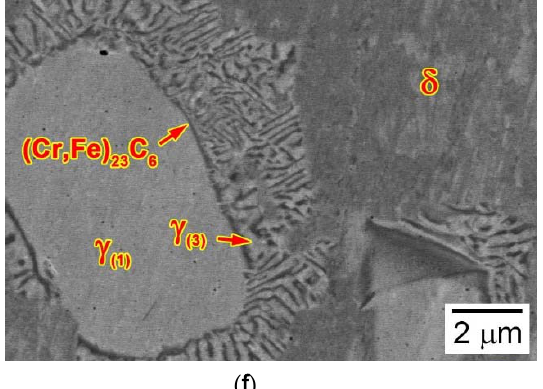
Figure 6. ( a ) Optical image of alloy 3C2N showing the liquid-metal quenched longitudinal macro-grain structure of the DS bar after the LMC-DS processing; SEM-BSE images were taken at distances of ( b ) 10, ( c ) 20, ( d ) 30, and ( e ) 40 mm away from the liquid-solid interface in Figure 6a, showing the microstructural evolution in the steady-state zone and the competitive zone; ( f ) is an enlarged SEM-BSE image of typical (Cr,Fe) 23 C 6 carbide and δ -ferrite acquired from Figure 6d.